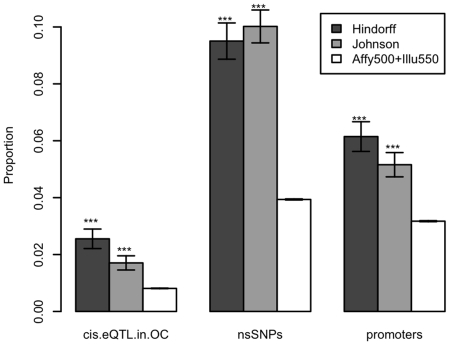
Annotation proportions in the Hindorff and Johnson GWAS hit datasets
and a GWAS panel set.The proportion of annotation is shown for three different categories (cis
eQTL in open chromatin, nsSNPs and promoter SNPs).
“***” indicates p-values
<2.8×10−5
( = 0.001/36); “**” indicates
p-values <2.8×10−4
( = 0.01/36); “*” indicates
p-values <1.4×10−3
( = 0.05/36). These thresholds were chosen to
reflect a Bonferroni correction of the 36 comparison tests implicit in
Figures 1 and
2. The error
bars represent the standard error of the estimated proportions (normal
approximation to binomial distribution). The GWAS panel set is comprised
of a union of Affymetrix 500k and Illumina 550k panels.